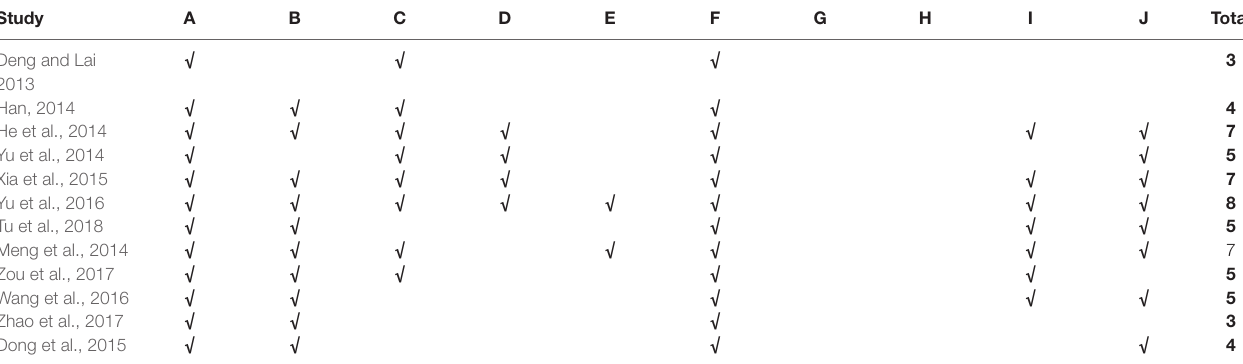
TABLe 4 | Risk of bias of the included in vivo